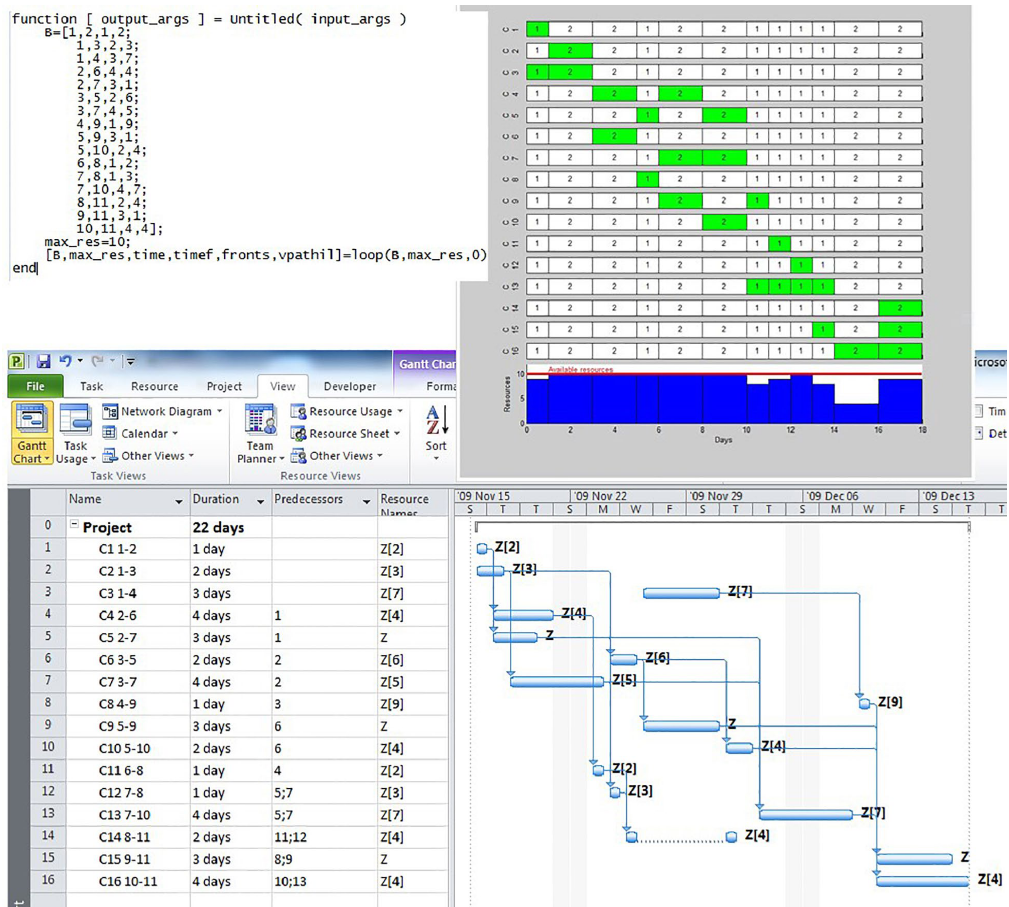
Fig. 3. A solution for Network 1 using FROPT and MSP